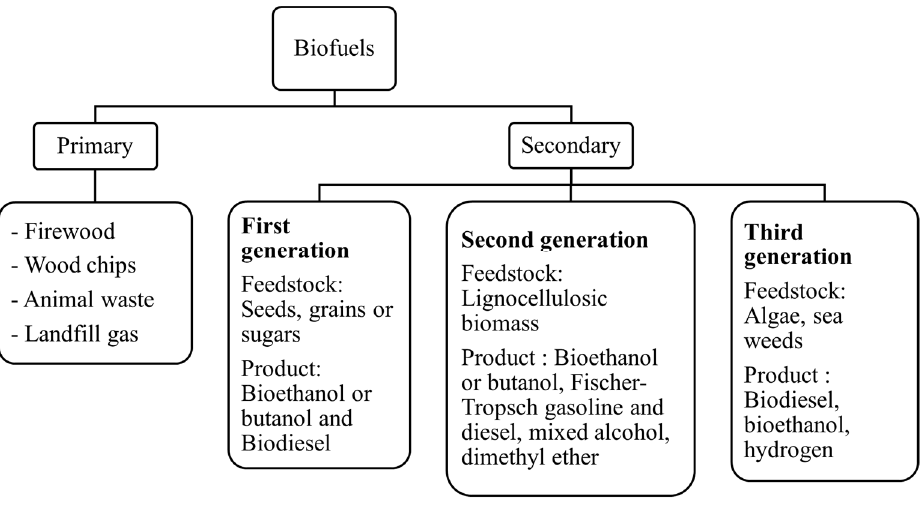
Figure 1. Classification of biofuels [9] .